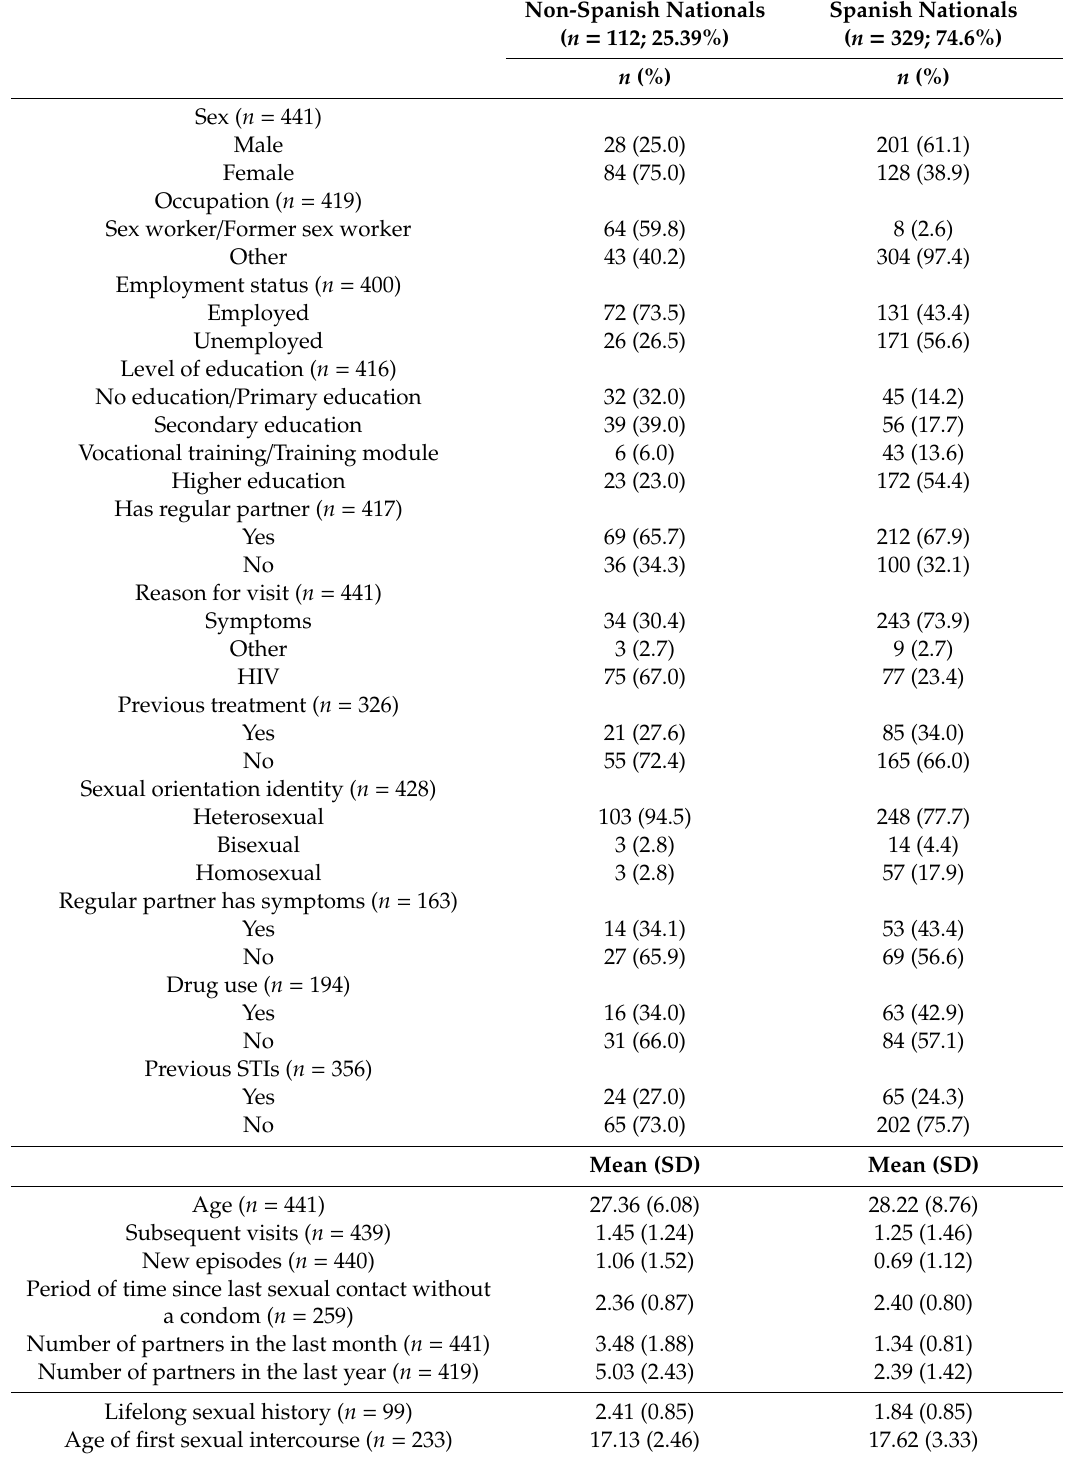
Table 1. Sample description of people diagnosed with a sexually transmitted infection (STI) by nationality (Spanish or non-Spanish) ( n =